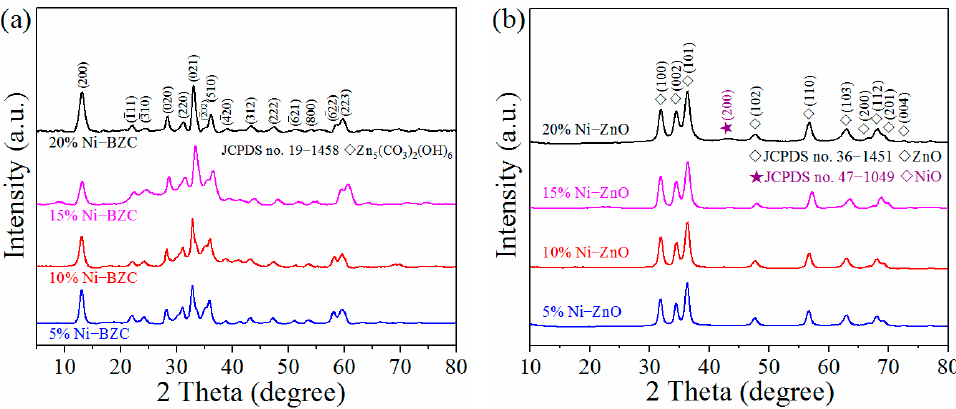
Figure 1. XRD patterns of ( a ) Ni-doped Zn 5 (CO 3 ) 2 (OH) 6 precursors and ( b ) Ni-doped ZnO